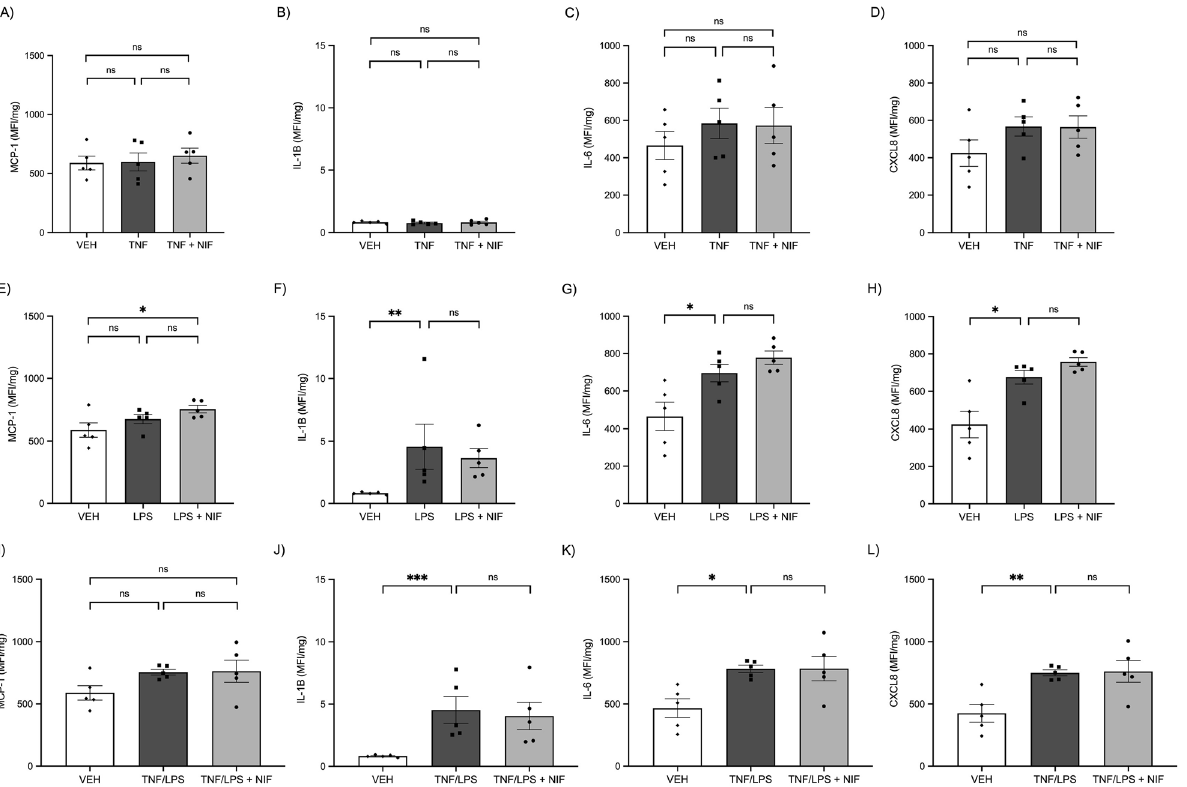
Figure 6. Treatment of human myometrial tissue with ( A–D ) TNF (1 ng/ml), ( E–H ) LPS (5 ng/ml), and ( I–L ) concurrent TNF and LPS, and co-treatment with nifedipine (NIF). TNF does not induce secretion of MCP-1 ( A ), IL-1B ( B ), IL-6 ( C ) or CXCL8 ( D ) compared with vehicle control (VEH). Addition of nifedipine (10 µM) does not have any effect when compared with vehicle. LPS does not increase MCP-1 secretion ( E ), but does induce a significant increase in production and secretion into culture media of IL-1B ( F ), IL-6 ( G ), and CXCL8 ( H ) and co-treatment with nifedipine does not reduce this increased secretion. Concurrent treatment with TNF and LPS does not increase secretion of MCP-1 ( I ) but does increase secretion of IL-1B ( J ), IL-6 ( K ), and CXCL8 ( L ). Data is expressed as the median fluorescence intensity (MFI) of technical replicates as measured by Luminex assay normalised to the mass of tissue (mg). Treatments were performed in duplicate and individual data points represent the mean of those technical replicates ( n = 5 experiments). Statistical analysis was performed on the log2 transformation of the MFI/mg using an ANOVA followed by Tukey’s multiple comparisons. The error bars represent SEM, * indicates P < 0.05, ** indicates P < 0.01, *** indicates P < 0.001, and ns indicates no statistical